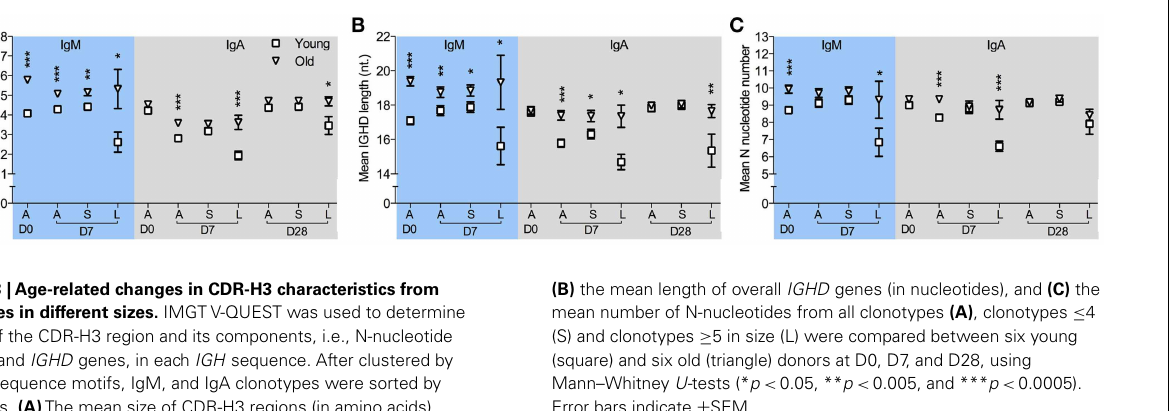
FIGURE 3 |Age-related changes in CDR-H3 characteristics from clonotypes in different sizes. IMGTV-QUEST was used to determine the size of the CDR-H3 region and its components, i.e., N-nucleotide numbers and IGHD genes, in each IGH sequence. After clustered by CDR-H3 sequence motifs, IgM, and IgA clonotypes were sorted by clone sizes. (A) The mean size of CDR-H3 regions (in amino acids),